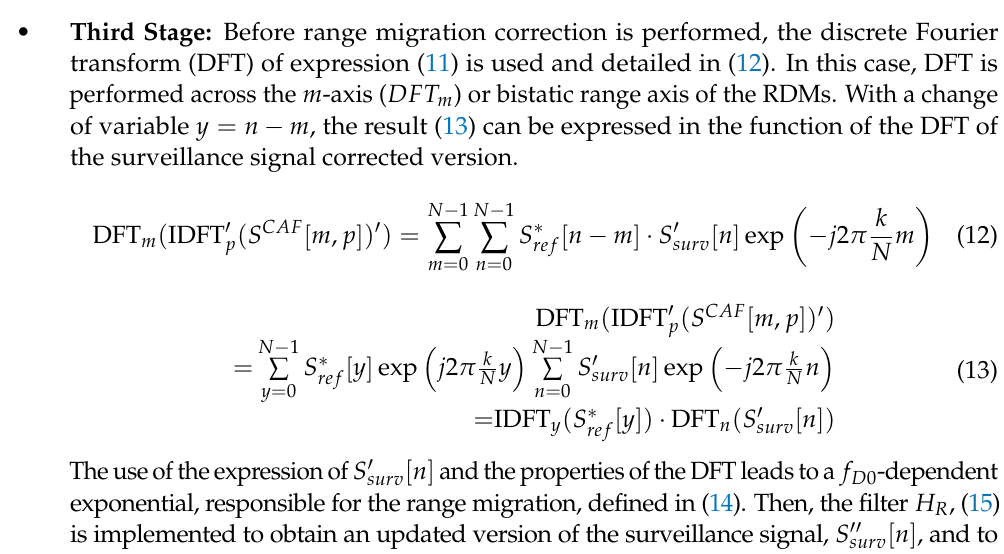
Figure 8. Doppler migration filter banks for a specific